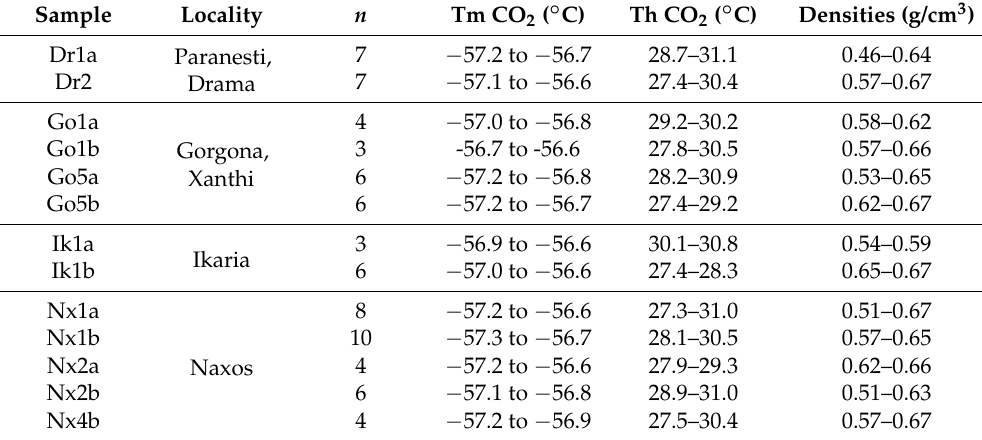
Table 5. Microthermometric data of studied primary and pseudosecondary fluid inclusions from corundum crystals in